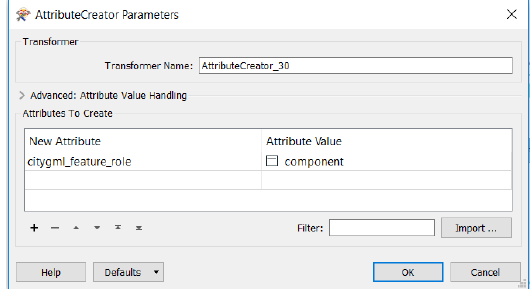
Figure 5. Example of assignment of the role name